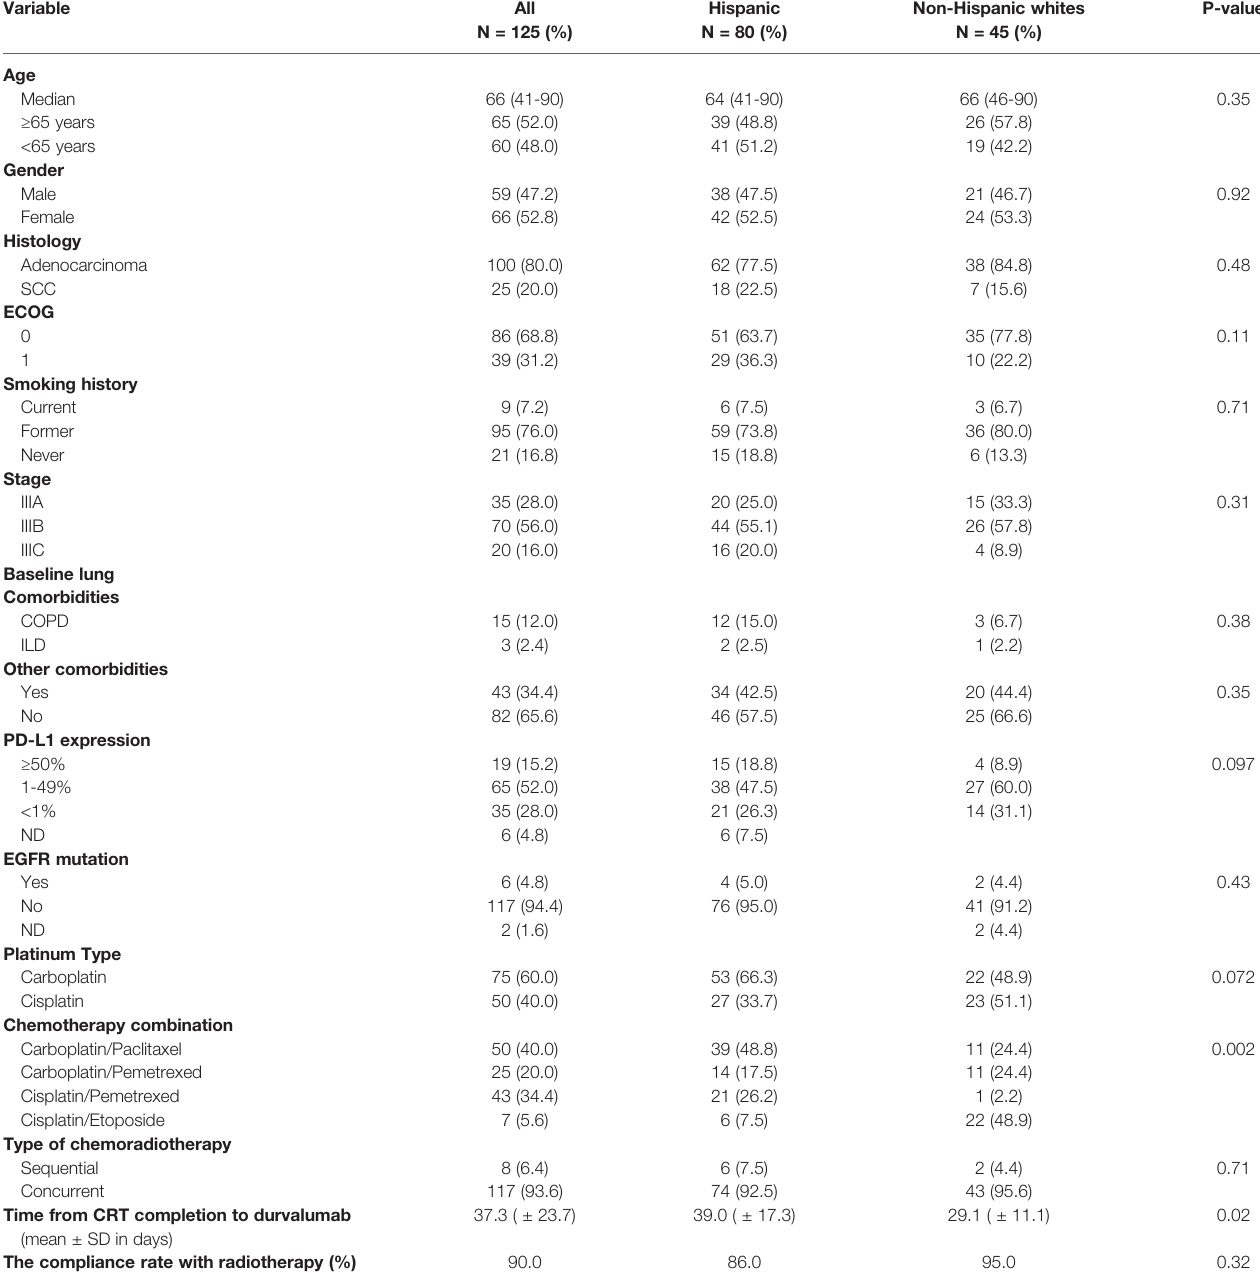
TABLE 1 | Baseline patient and treatment